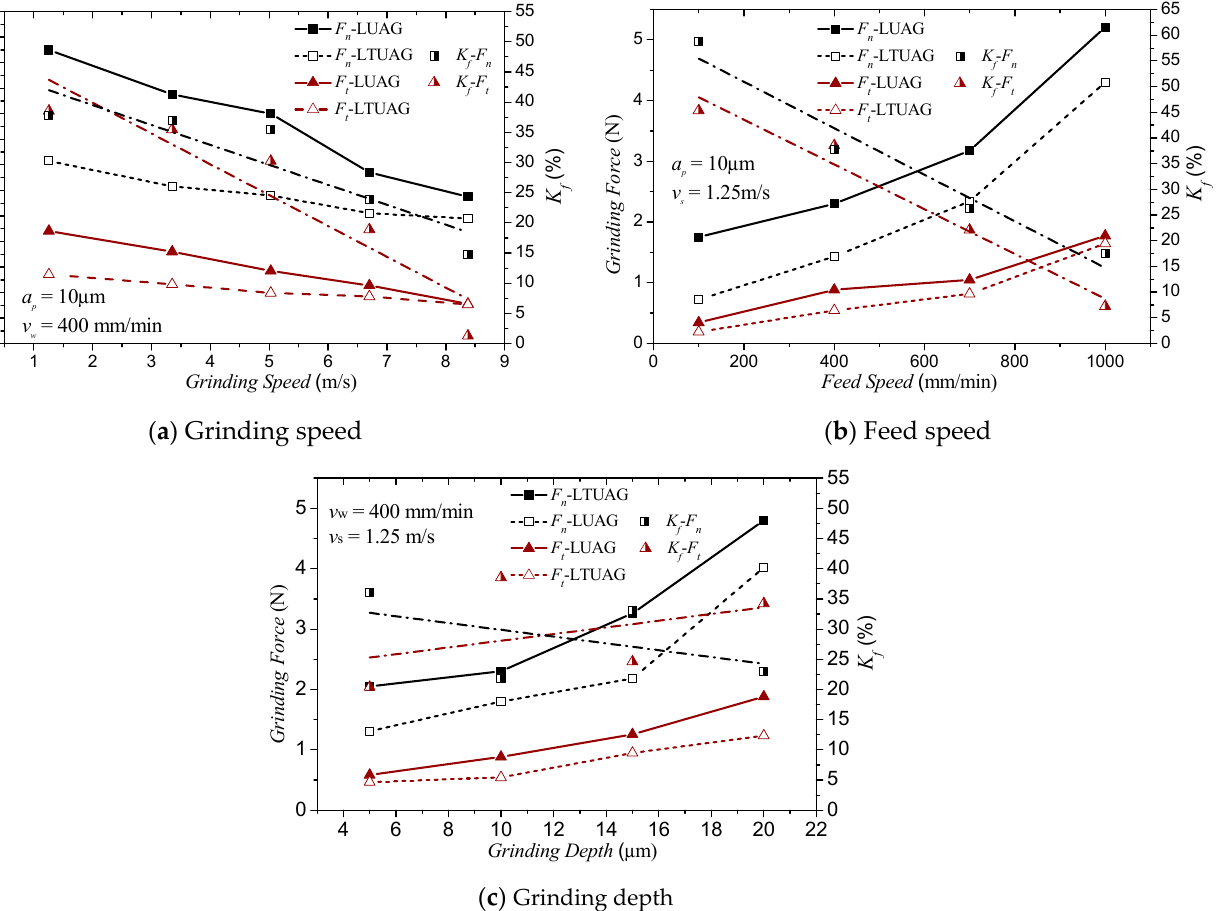
Figure 12. Effect of grinding parameters on grinding force ( K f is the reduction rate of the grinding force produced by LTUAG compared to the grinding force produced by LUAG, K f = ( F LUAG − F LTUAG ) × 100%/ F LUAG